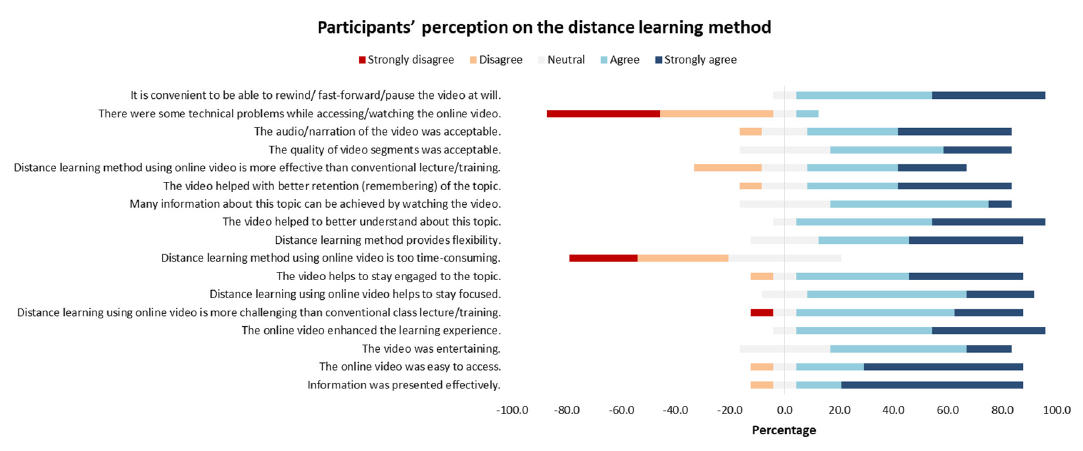
Figure 3. Participants’ perception on the distance learning method as evaluated by the Likert-type scale questionnaire. Colours indicate the level of agreement (strongly agree, agree, neutral, disagree or strongly disagree). Horizontal axis depicts percentage of participants’ agreement for each statement.